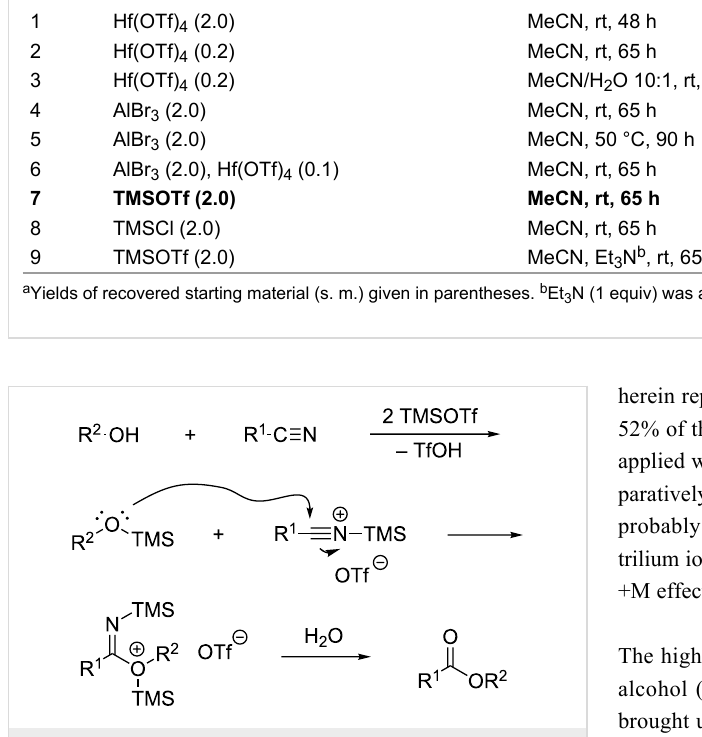
Scheme 5: Plausible mechanism of the Lewis acid-promoted Pinner